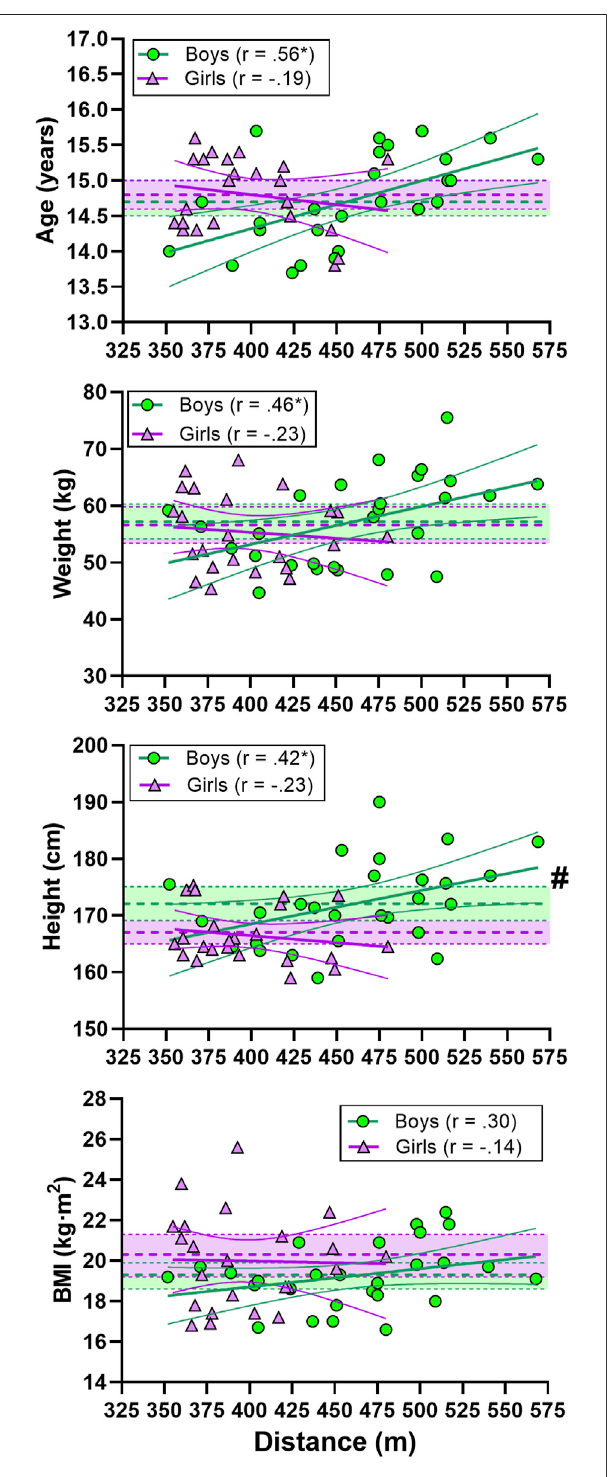
Frontiers in Physiology |